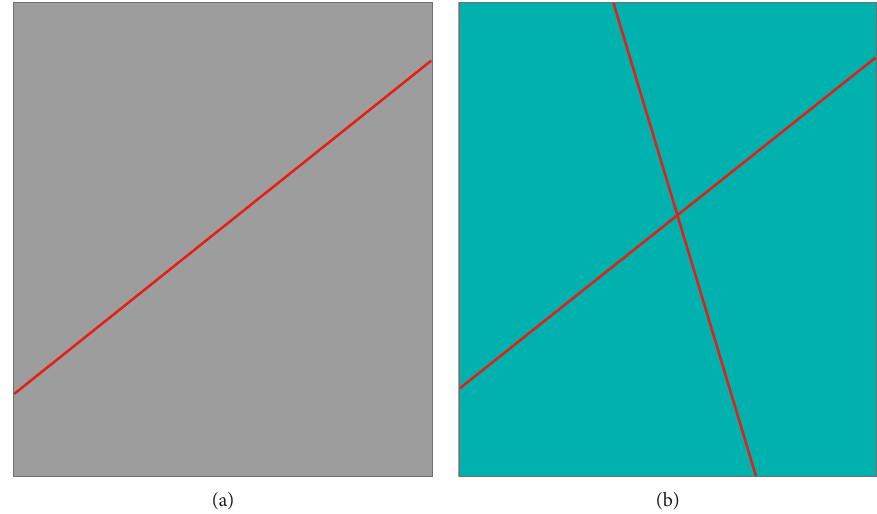
Figure 2: Two types of fracture cells in the EFC approach: type I represents the grid cell intersected by only one fracture (a) and type II indicates the grid cell intersected by more than one fracture